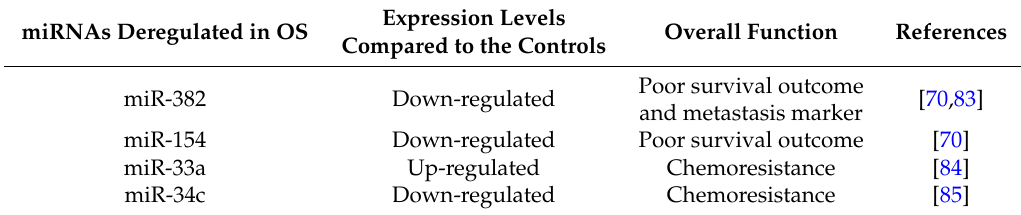
Table 1. miRNAs as potential markers for survival outcome and/ or chemosensitivity. Expression miRNAs Deregulated in OS